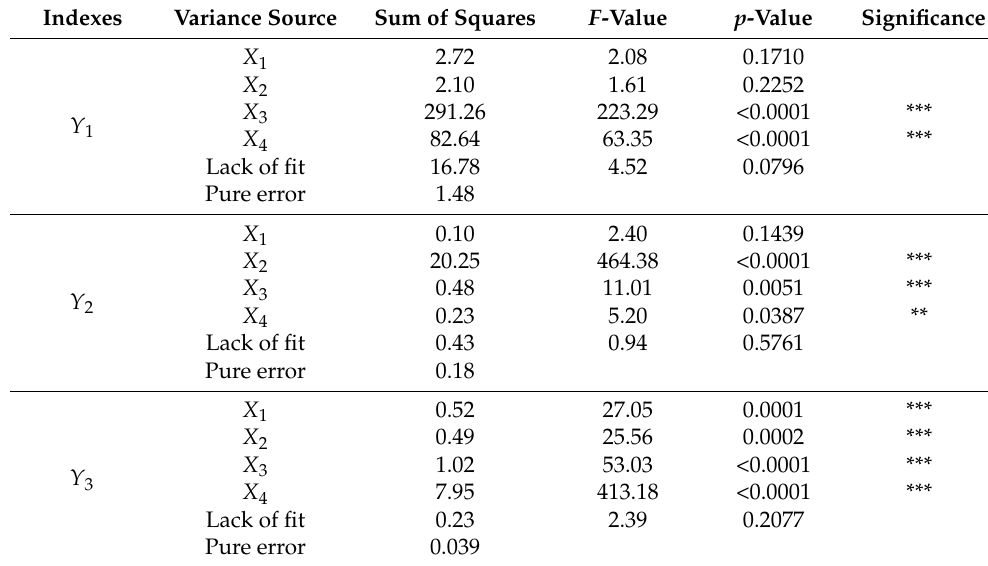
Table 6. Variance analysis of regression